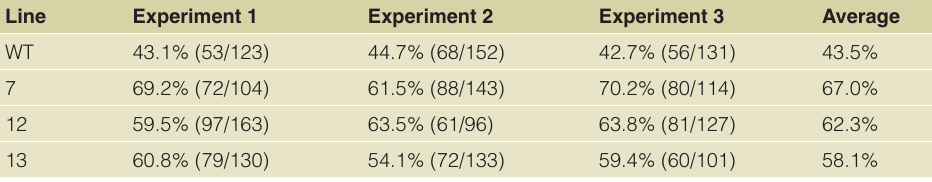
Table 1. Percentage of root segments staining positive for β -glucuronidase.